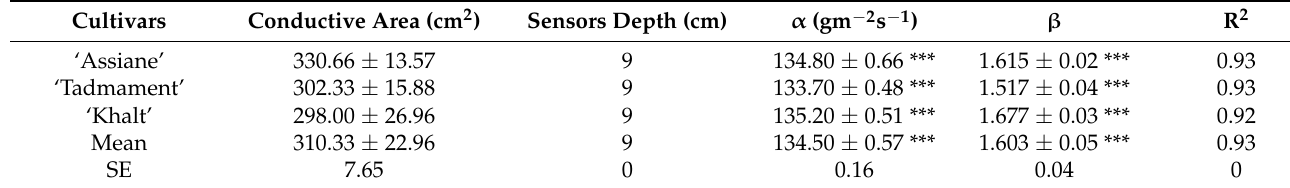
Table 2. Regression coefficients calibrated for sap flux density measurements.